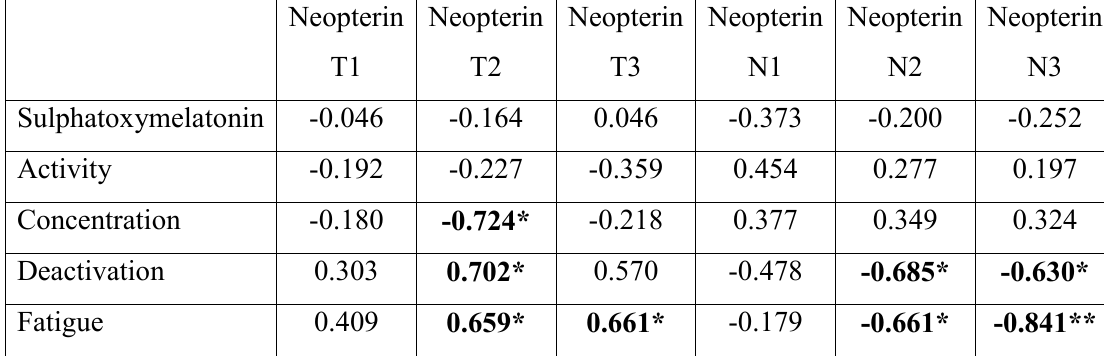
Table 3. Correlation between neopterin and sulphatoxymelatonin measured in urine specimens collected at ∼ 06:00 h as well as selected parameters of mood rating inventory surveyed at ∼ 06:00 h (EWL adjective check list of Janke and Debus  , Hogrefe Verlag, Goettingen. Germany) of three consecutive nights in a lighting environ- ment with reduced short-wavelength components (T) or in an unfiltered bright light environment (N). Non-para- metric Spearman rank correlations were calculated. Data represent correlation coefficients (rs), and significant rs are written in bold shape (*p < 0.05, **p <